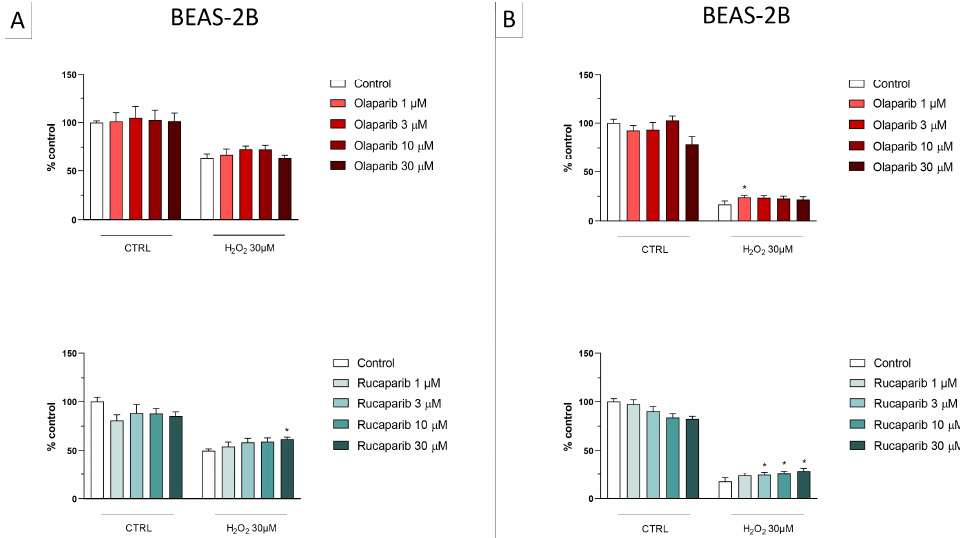
Figure 6. Effect of the clinical-stage PARP inhibitors olaparib or rucaparib on H 2 O 2 -induced sup- pression of cellular MTT-converting activity in BEAS-2B cells. Cells were treated for 2 h ( A ) or 24 h ( B ) with 30 µM H 2 O 2 ; the PARP inhibitors were applied at different concentrations (1, 3, 10, and 30 µM). * p < 0.05 indicates the beneficial effect of PARP inhibition to counteract the effect of oxidative stress. Data are shown as mean ± SEM of n = 5 independent experiments.